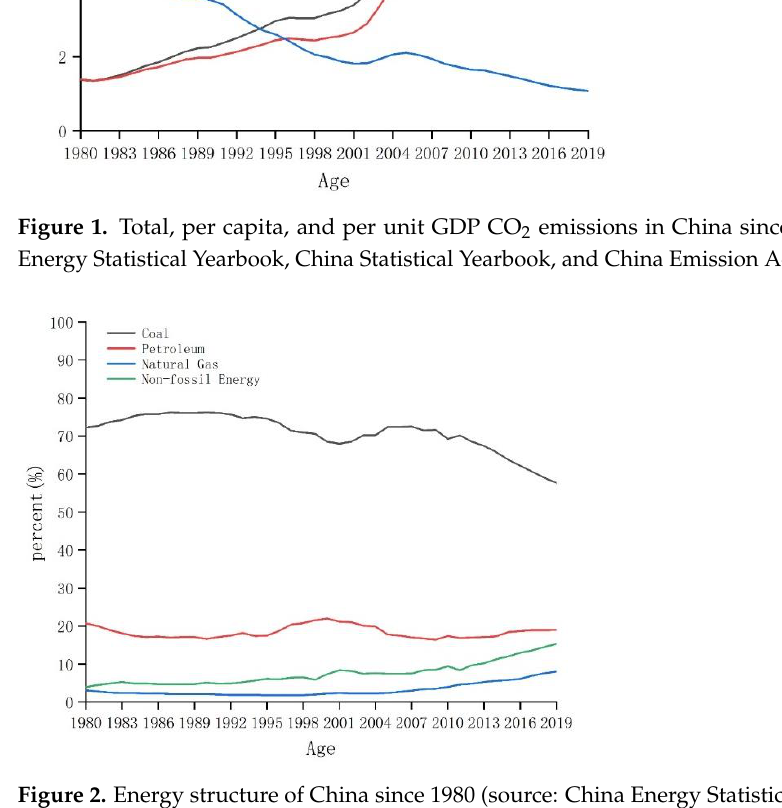
Figure 2. Energy structure of China since 1980 (source: China Energy Statistical Yearbook).